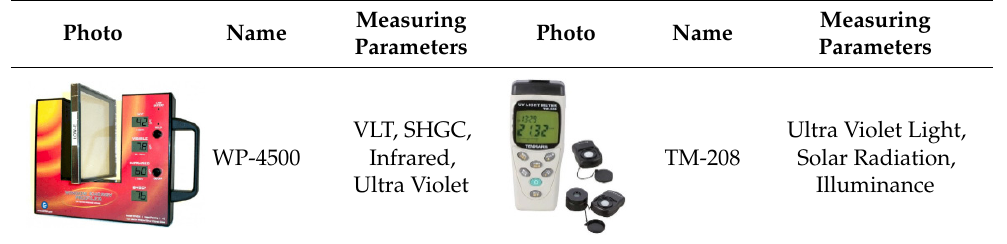
Table 3. Equipment used for the mock-up test.